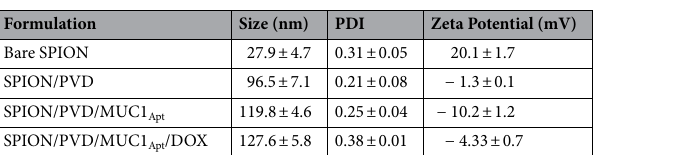
Table 1. DLS analysis of the prepared